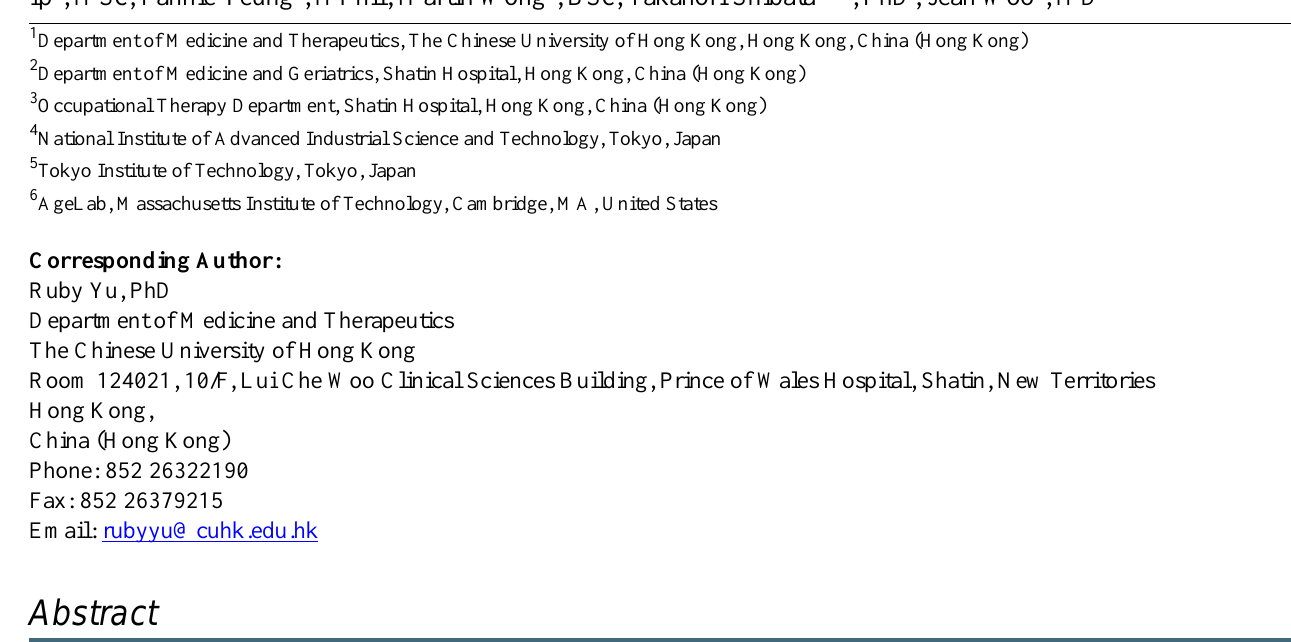
(Archived by WebCite